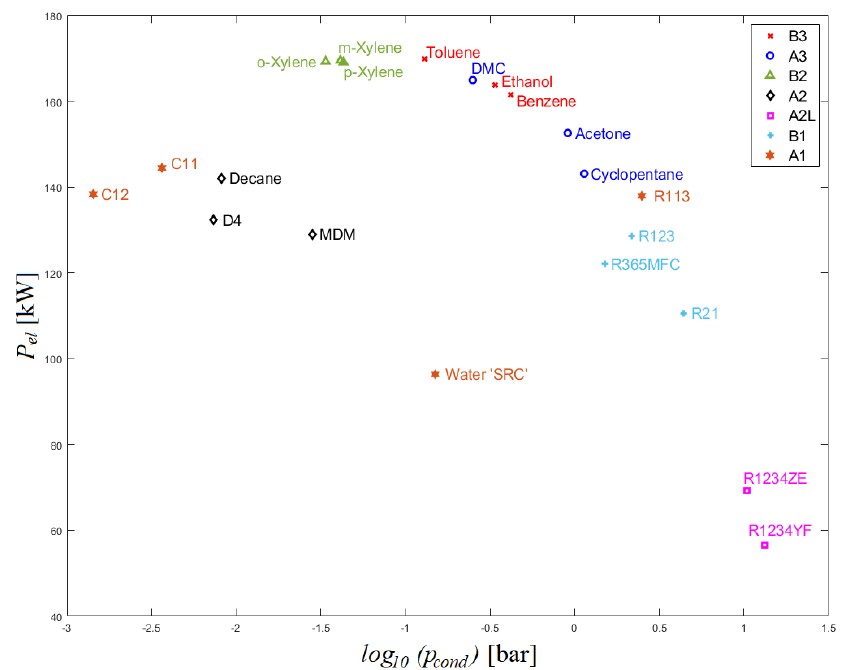
Figure 8. Net output power versus condensation pressure (in logarithmic scale) of the best 3 fluids of each safety category in the case of no thermal loop.